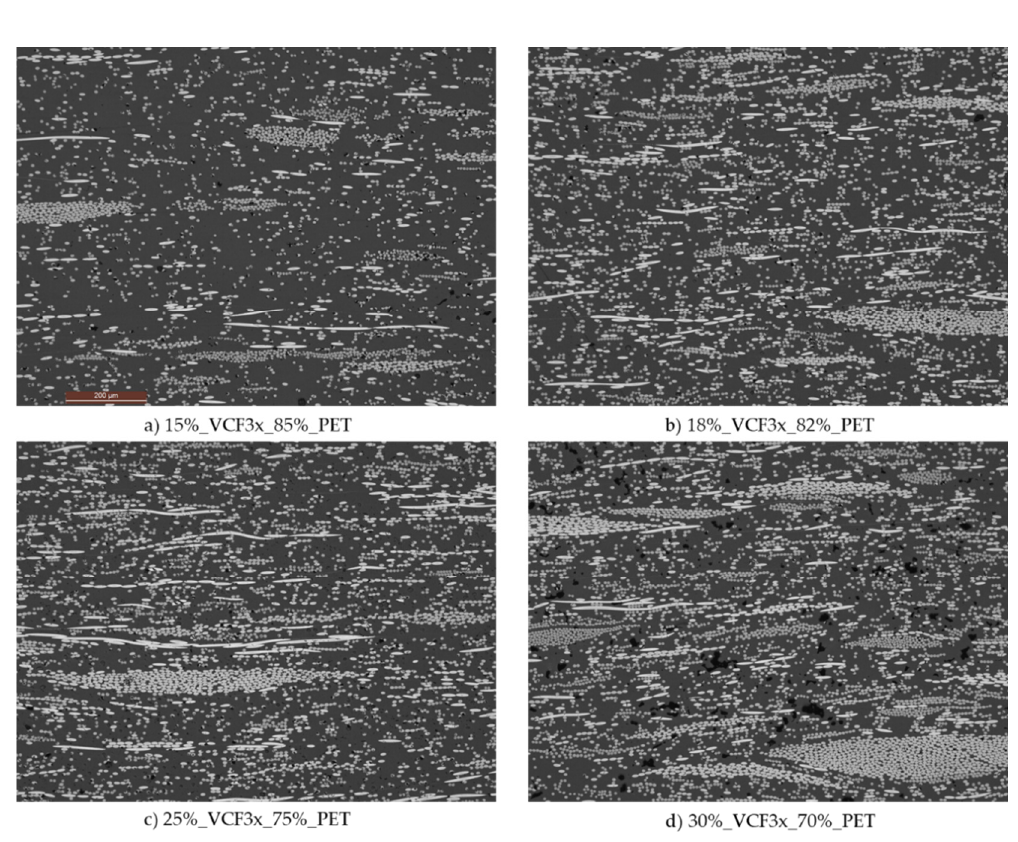
Figure 6. Cross section images of PET nonwoven with different fiber volume contents. ( a ) 15%, ( b ) 18%, ( c ) 25%, and ( d ) 30% fiber volume content. All with the same resolution. Red bar in picture ( a ) indicates 200 µm.